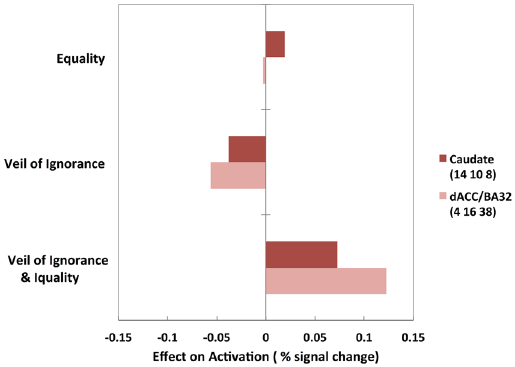
Figure 5. The caudate nucleus was activated by an equality decision, but the dACC activation depended on the presence of the VoI. An equality decision increased the activation of only the caudate nucleus and thus reduced activation of the dACC. The VoI condition reduced the activation of both brain regions but more so that of the dACC than the caudate nucleus. When the effects of the two factors (an equality decision and the VoI) were combined (i.e., when an equality decision was made behind the VoI), activation of the dACC was greater than that of the caudate nucleus. Caudate nucleus: 4, 10, 8; FWE-corrected p = 0.029 for multiple comparisons across the whole brain; k = 13. dACC: 4, 16, 38; FWE-corrected p = 0.006 for multiple comparisons across the whole brain; k = 116.